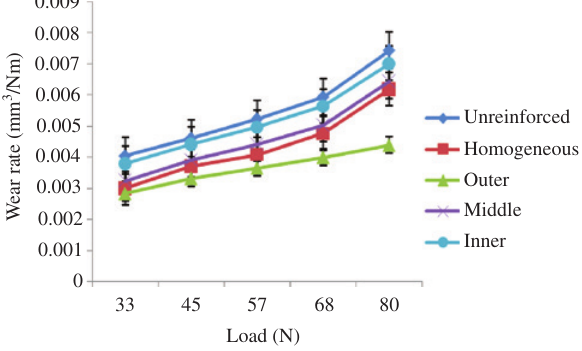
Figure 9: Effect of load on the alloy and composite surfaces at a constant speed of 200